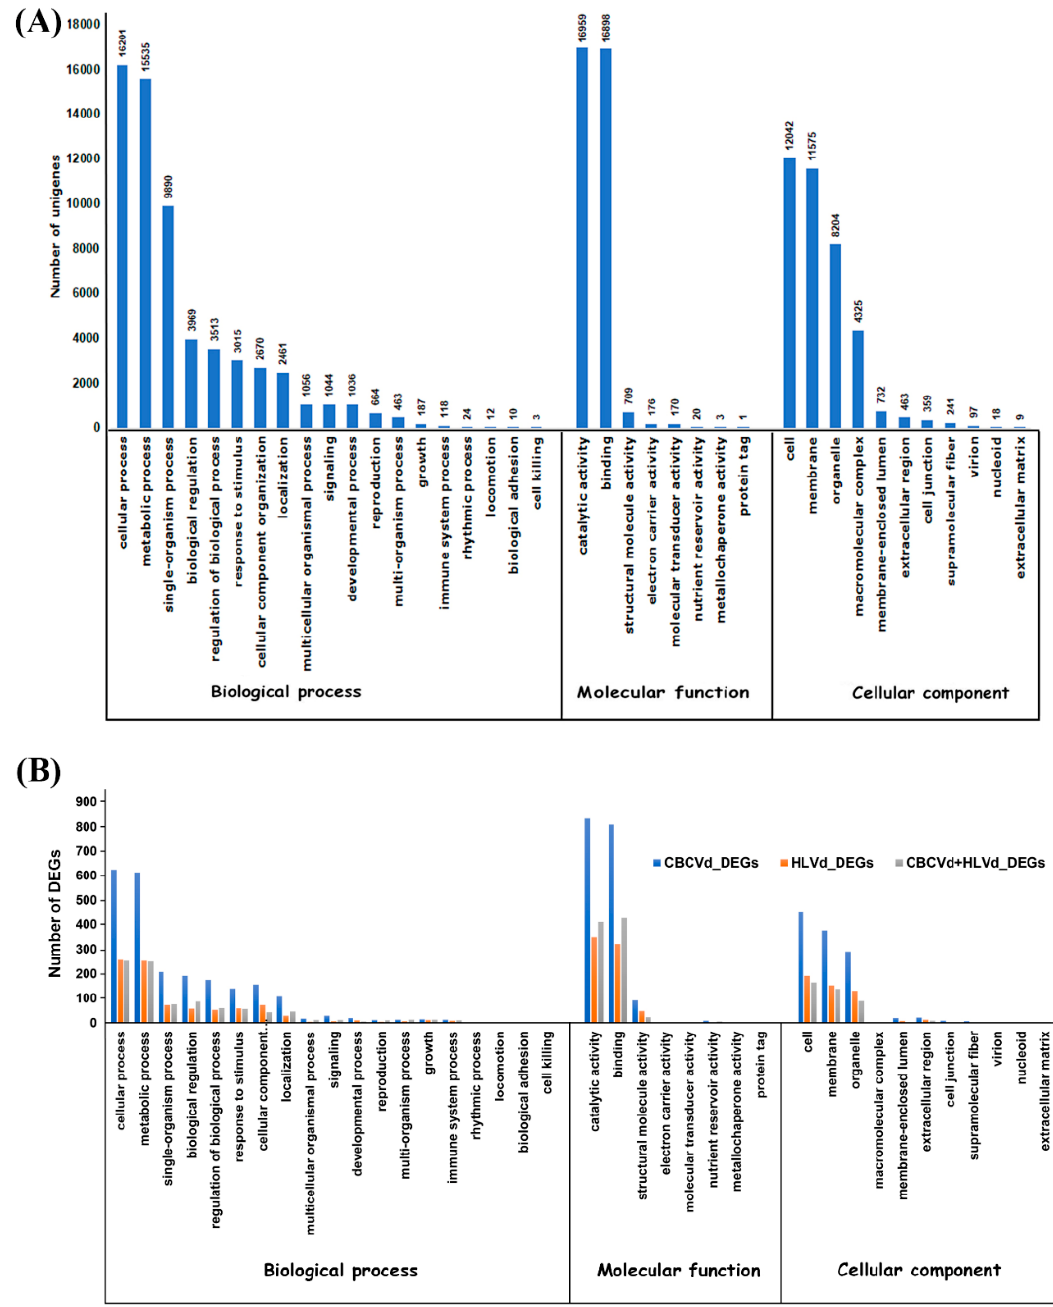
Figure 2. Histogram representation of Gene Ontology (GO) classification annotated transcripts of hop ( A ) and the differentially expressed genes in single CBCVd, HLVd infected, and HLVd-CBCVd coinfected hop ( B ) in three categories: Cellular components, molecular function, and biological processes.